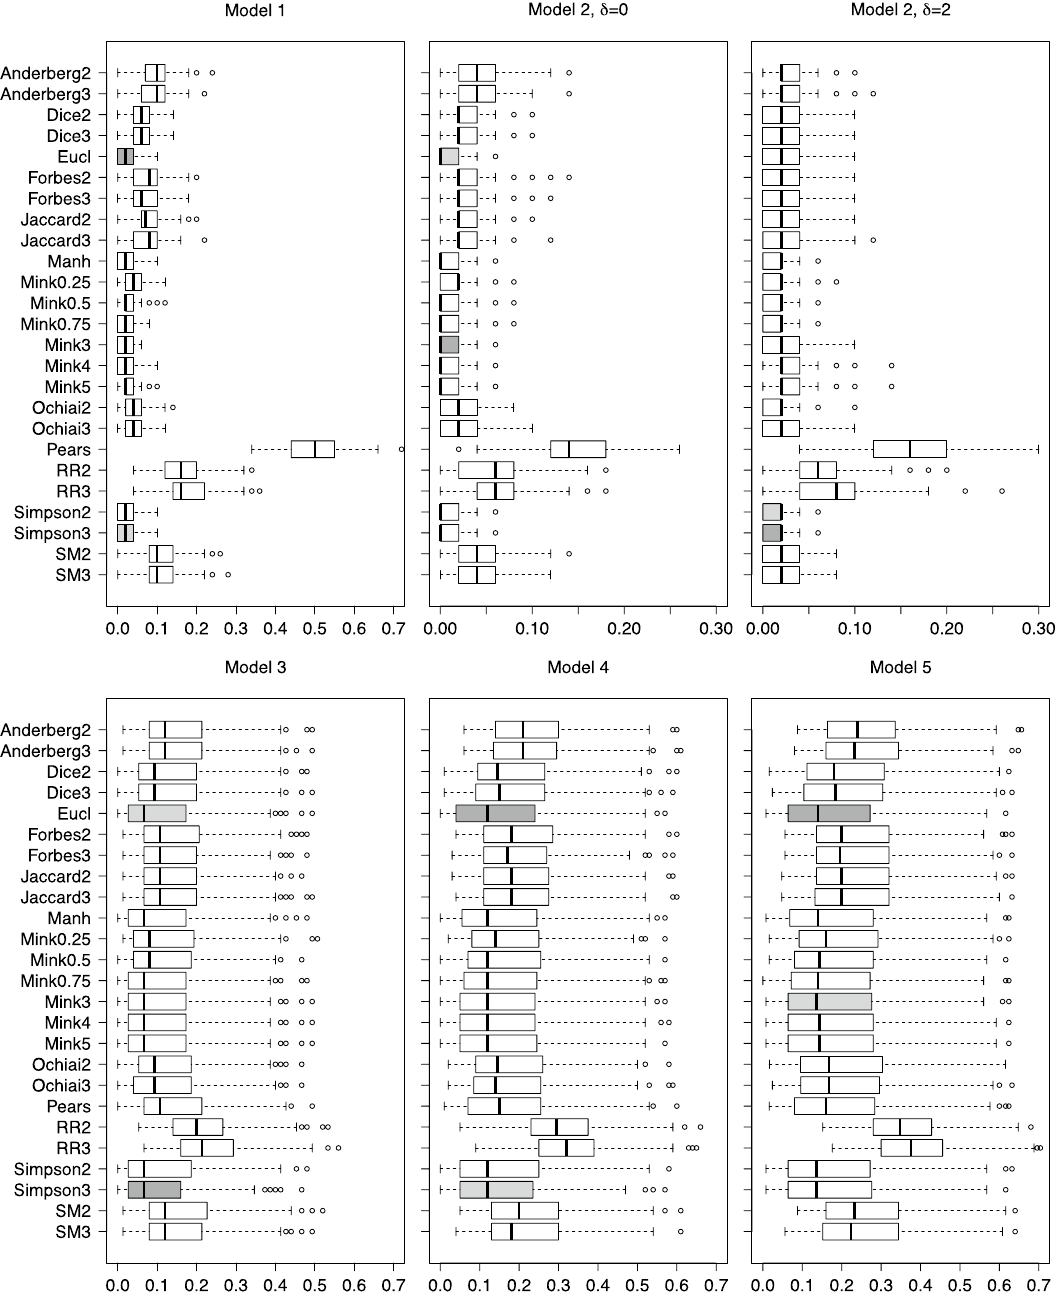
Figure 3. Classification error rates in the simulated models. Distribution of the classification error rates over 200 test sets from Models 1–5 after running kNN, using the classical distances and the dissimilarity indices based on bands, for J = 2 and 3. Best and second best means are indicated with dark and light gray boxes, respectively. The number of observations in each class of the train and test sets is 100 and 25, Model 2 : It also has two groups, now with 10 independent variables; the last five ones are noise. The stand- ard deviation of a single noise variable is increased an amount δ ∈ { 0, 1, 2 } . The results corresponding to both extremes are displayed in Fig. 3, top-middle and top-right panels. When δ = 0 the classical distances classify the new observations better than the band-based dissimilarity indices, but they are closely followed by S. If sorted from lowest to highest average error rates, S ranks 7 and 9 for J = 2 and 3, respectively. Nevertheless, all the band-based measures except for RR yield average error rates lower than 0.05. Again, the Pearson correlation has the worst results. However, this model poses a critical scenario for the classical distances as the parameter δ rises. For δ = 2 , the corresponding error rates deteriorate and S becomes the best option, whereas, notably, the band-based alternatives (except RR) remain robust against the value of δ .